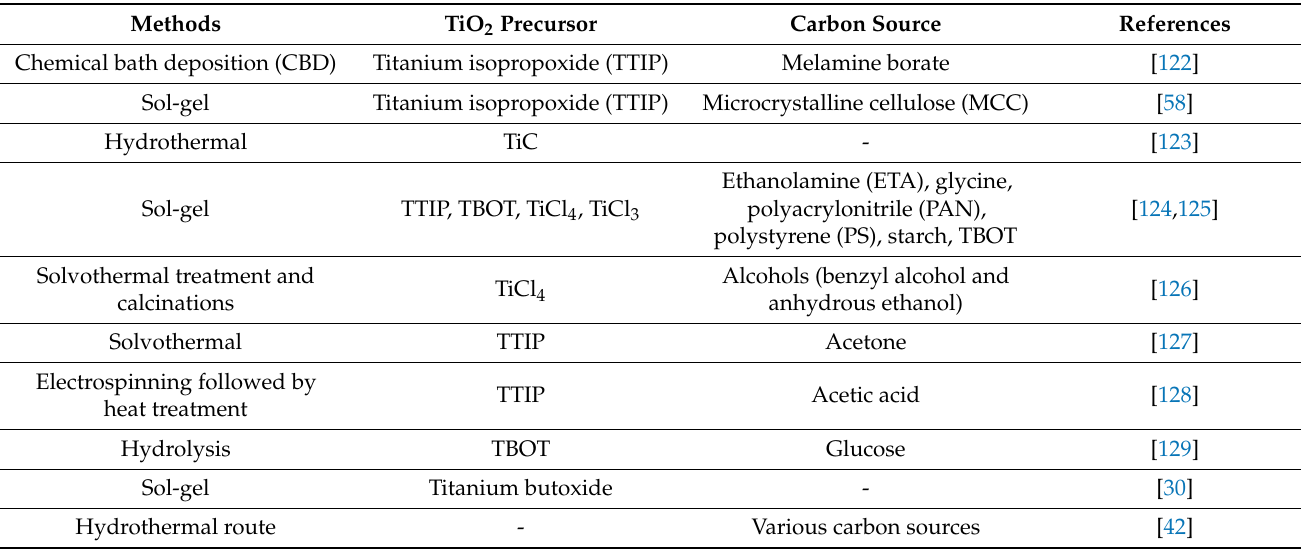
Table 4. Methods and precursors used for the synthesis of C-doped TiO 2